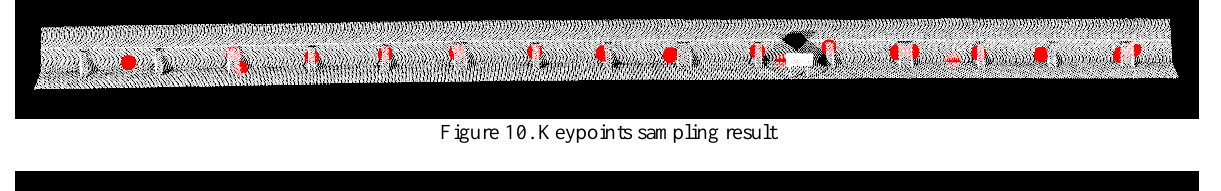
Figure 12. Decomposition result